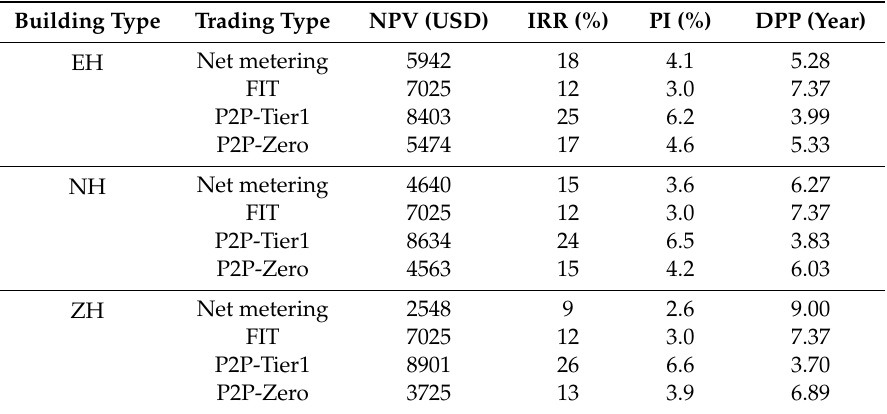
Table 17. Results of economic analysis by building types and trading